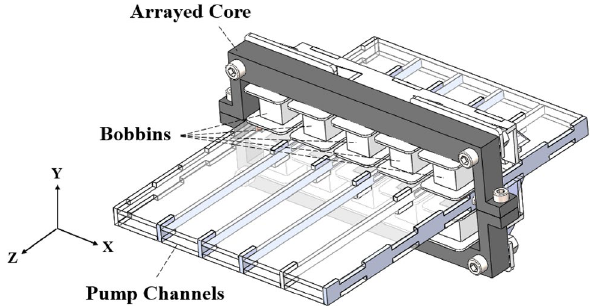
Fig. 4 The assembled view of the electromagnetic pump test track